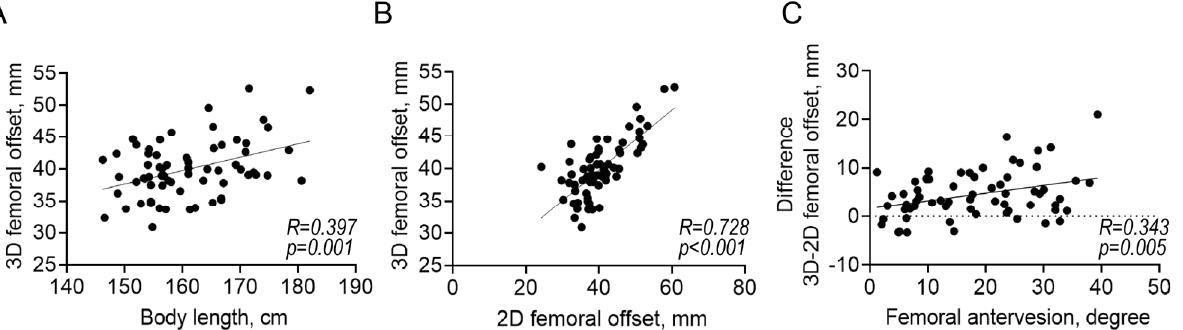
Figure 7. Correlations between ( A ) the body length and three-dimensional femoral offset, ( B ) two- dimensional and three-dimensional offset, and ( C ) femoral anteversion and difference three-two- dimensional femoral offset.